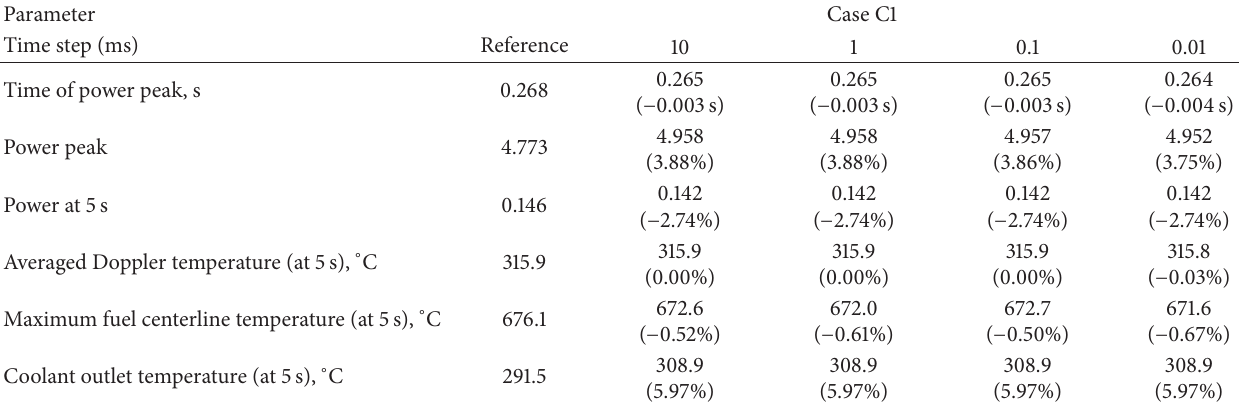
Table 8: Sensitivity analysis results in the maximum time step for case